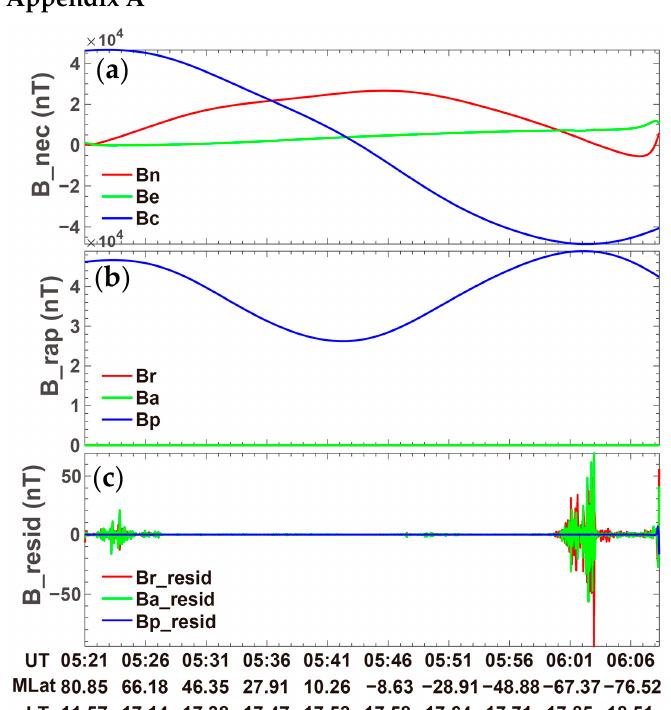
Figure A1. ( a ) Three magnetic field components in North-East-Center (NEC) coordinates; ( b ) three magnetic field components in local field-aligned coordinates; ( c ) residual magnetic field in local field-aligned coordinates.